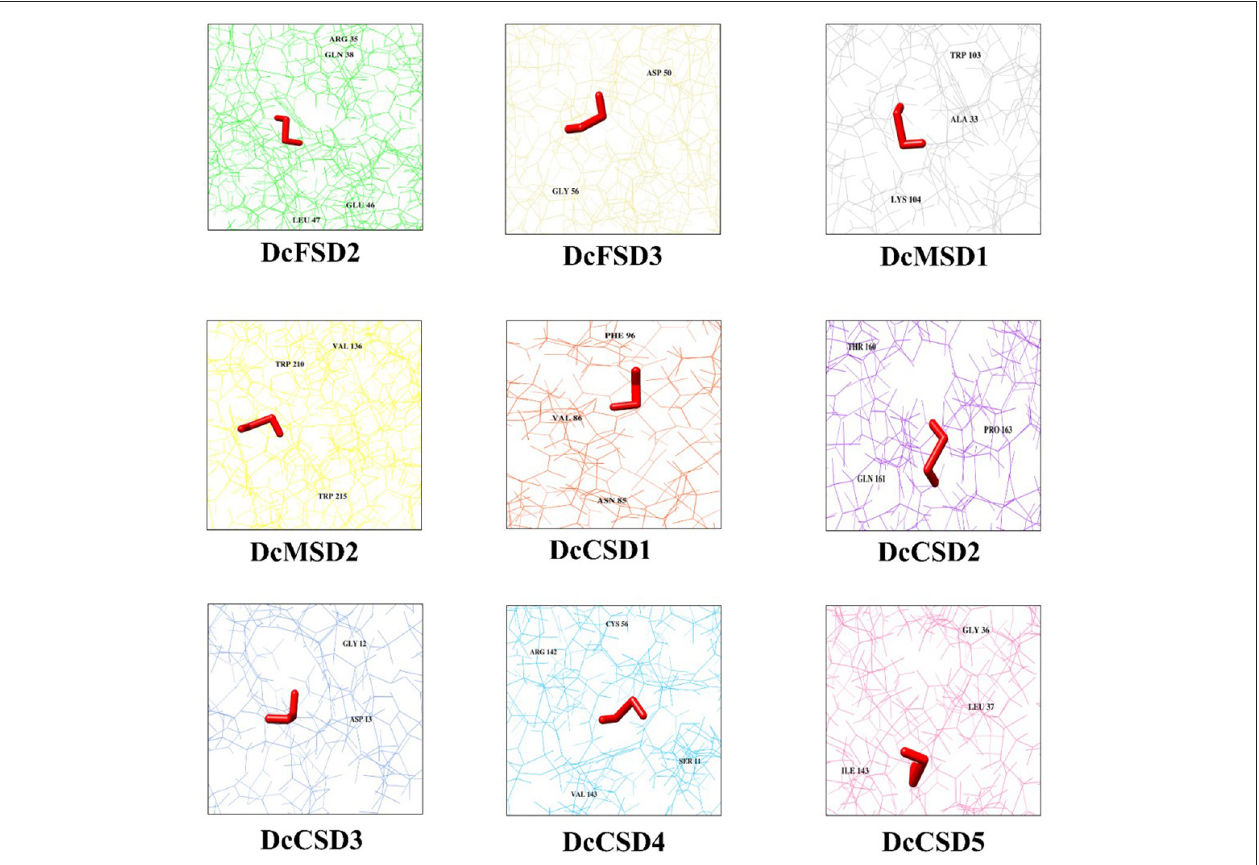
FIGURE 7 | H 2 O 2 docked against 9 DcSODs. The different color background of the diagram represents protein residues, conserved residues of the protein are also labeled, and the prominent red color represents the ligand (H 2 O 2 ).